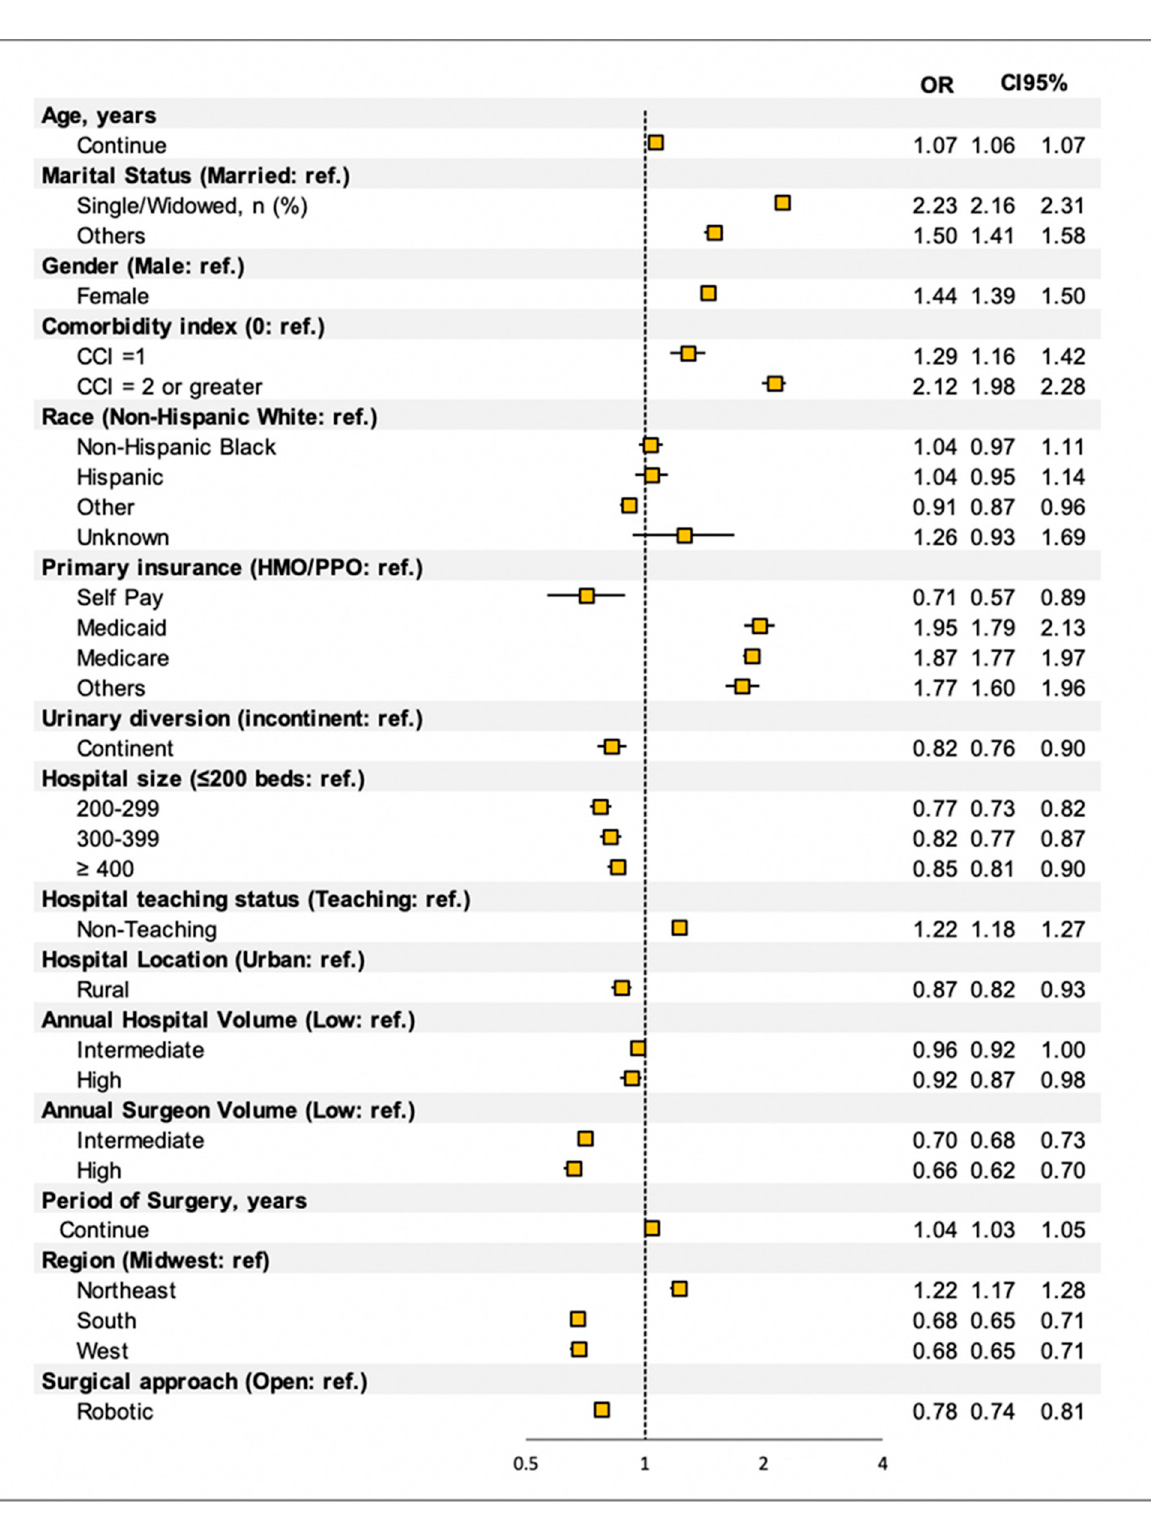
Figure 2. Multivariable Analysis Overall population. OR: Odds Ratio.